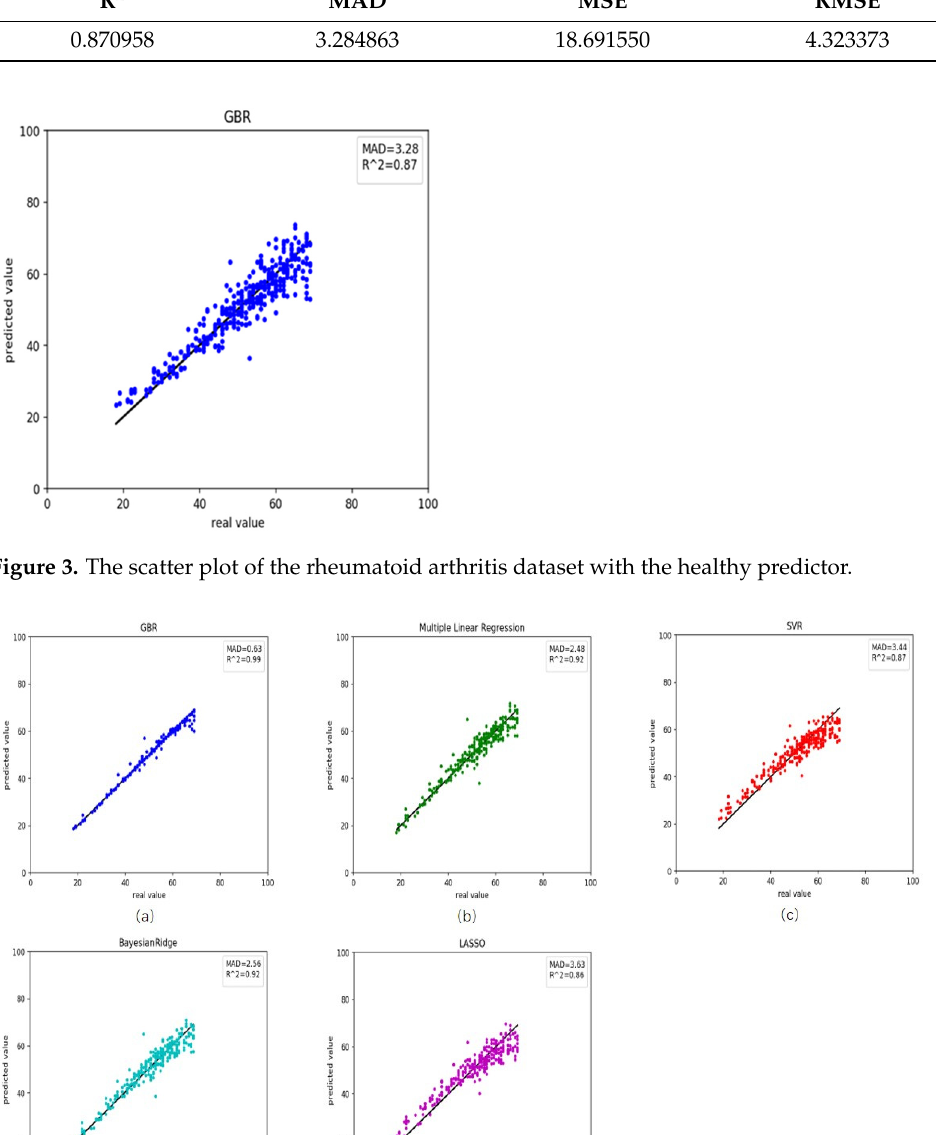
Figure 5. Comparison results between the actual age and predicted age by five different models on the testing rheumatoid arthritis data. ( a ) gradient boosting regression, ( b ) multiple linear regres- sion, ( c ) support vector regression, ( d ) Bayesian ridge regression and ( e ) lasso regression.